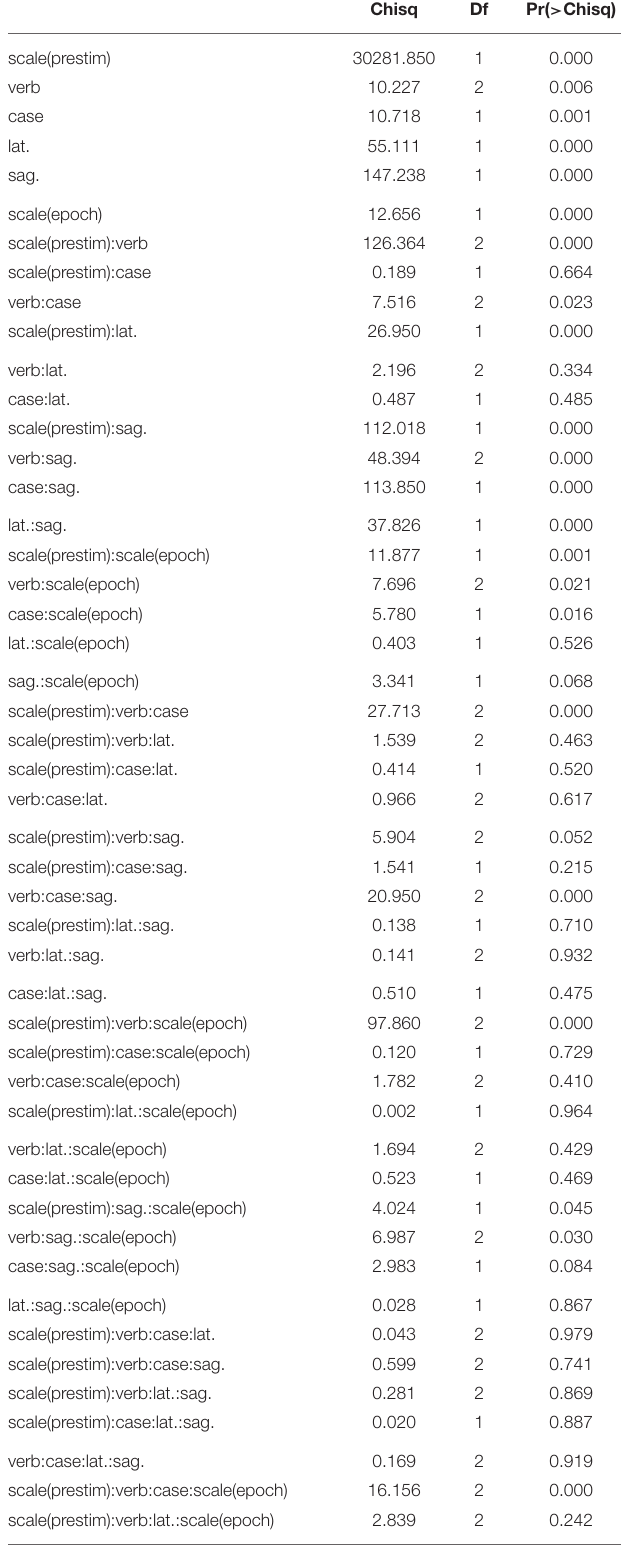
TABLE 3 | Summary of effects in Late Positivity time window (Type II Wald Tests).